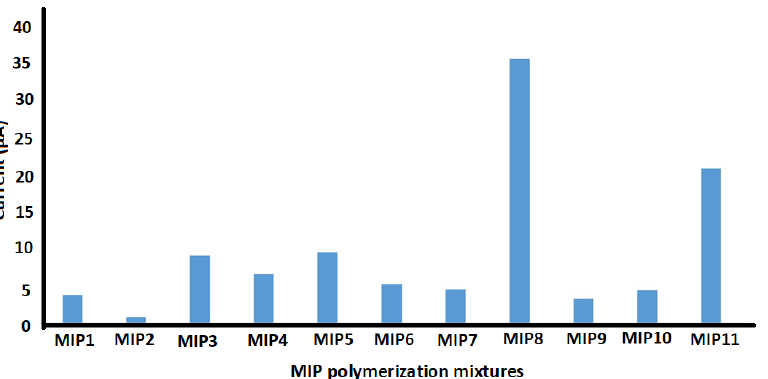
Figure 3. Electrochemical response of 10 mg L − 1 Rhodamine B in 1 M H 3 PO 4 using 11 distinct MIPs as electrochemical film modifiers for SPCE.